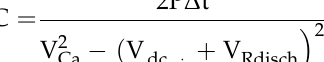
detection circuit sensed the STPI and controlled the switching of IGBTs, T c and T d which ensured that the voltage dip compensation module (VDCM) was switched onto the dc bus when required i.e., during the dip and taken out once the voltage STPI had cleared and C a fully